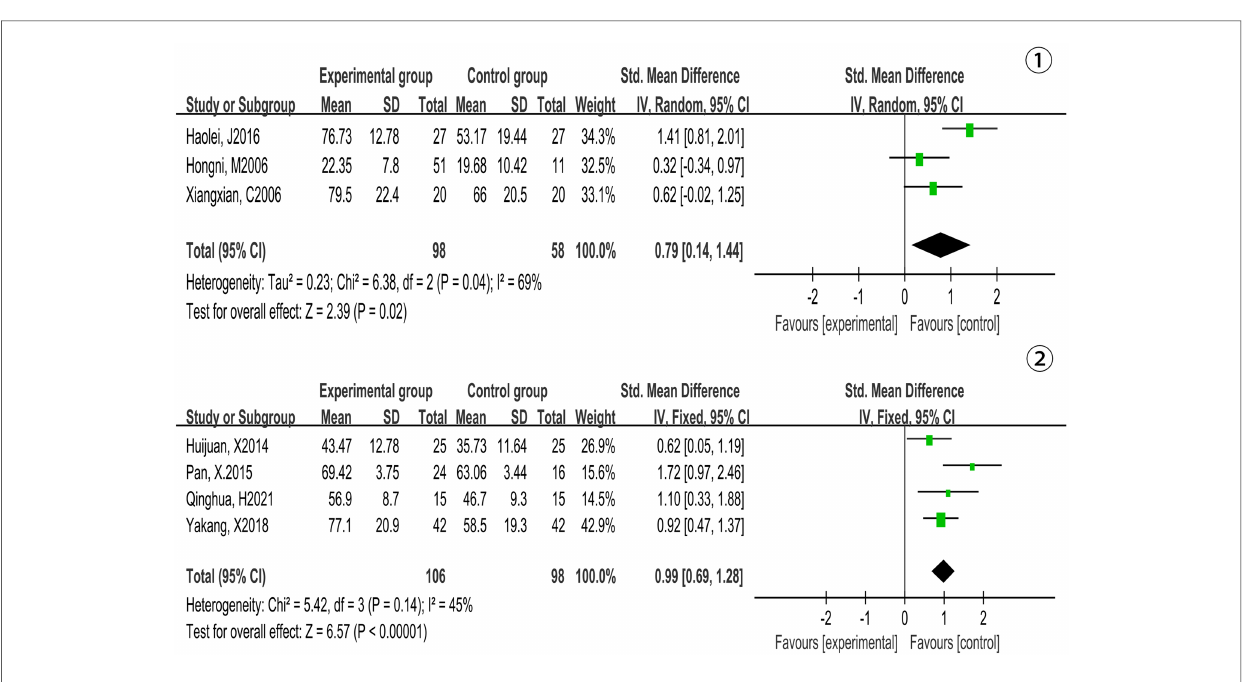
FIGURE 5 Forest plot of meta-analysis on the effect of Tai Chi exercise cycle on NO. Figure Notes: ① , Cycle <12 weeks; ② , Cycle ≥ 12